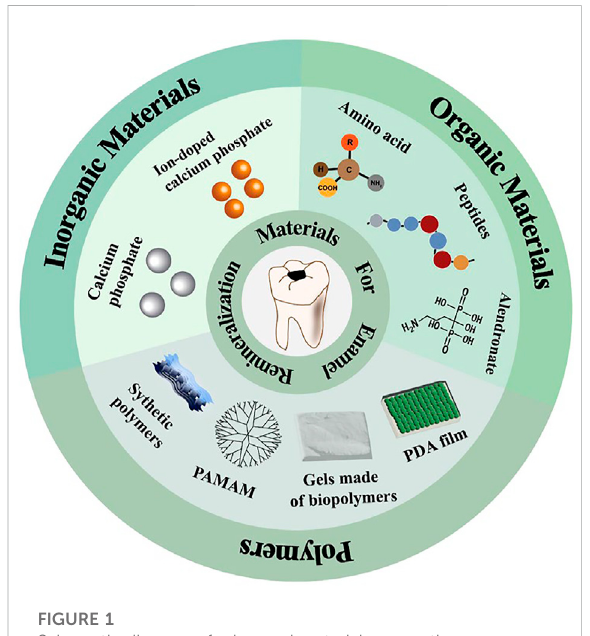
FIGURE 1 Schematic diagram of advanced materials promoting remineralization and repairing